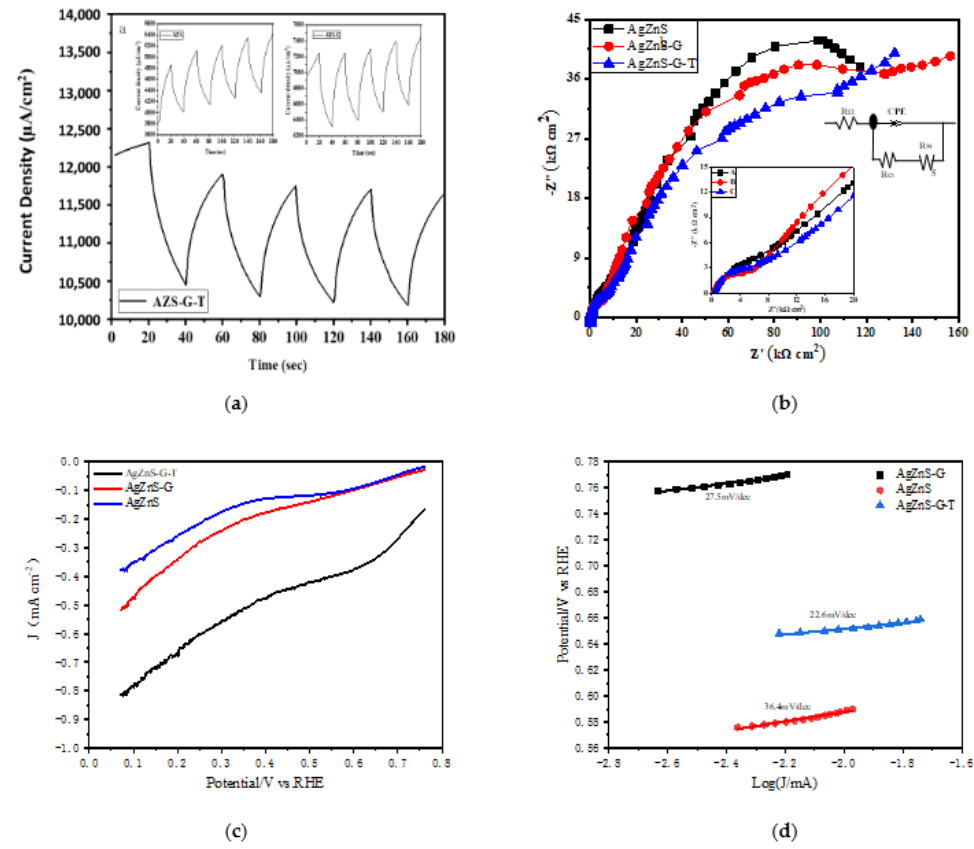
Figure 5. ( a ) Photocurrent response; ( b ) EIS Nyquist plots; ( c ) LSV data; ( d ) Tafel data of AgZnS, AgZnS-G, and AgZnS-G-T photocatalysts. AgZnS-G, and AgZnS-G-T